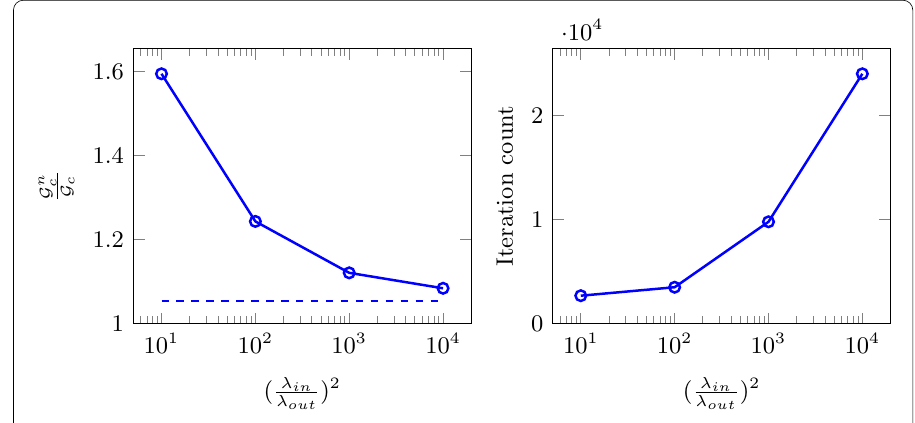
Fig. 5 The reduction of fracture energy error (left) and increase in linear iterations (right) as a function of length scale contrast Comparison of gradient and integral nonlocal damage